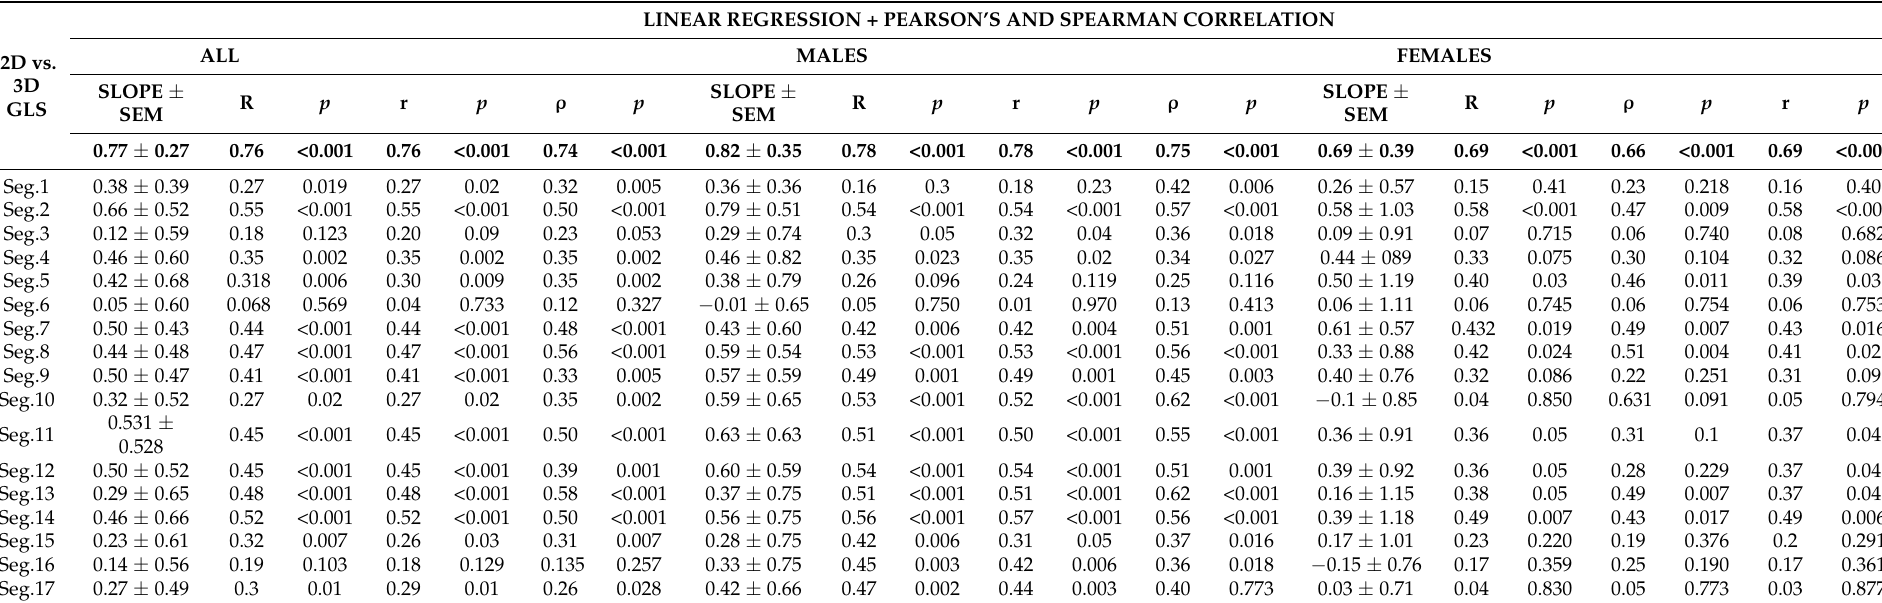
Table 2. Comparison of 2D vs. 3D global longitudinal strain, analyzed on entire group and separately by